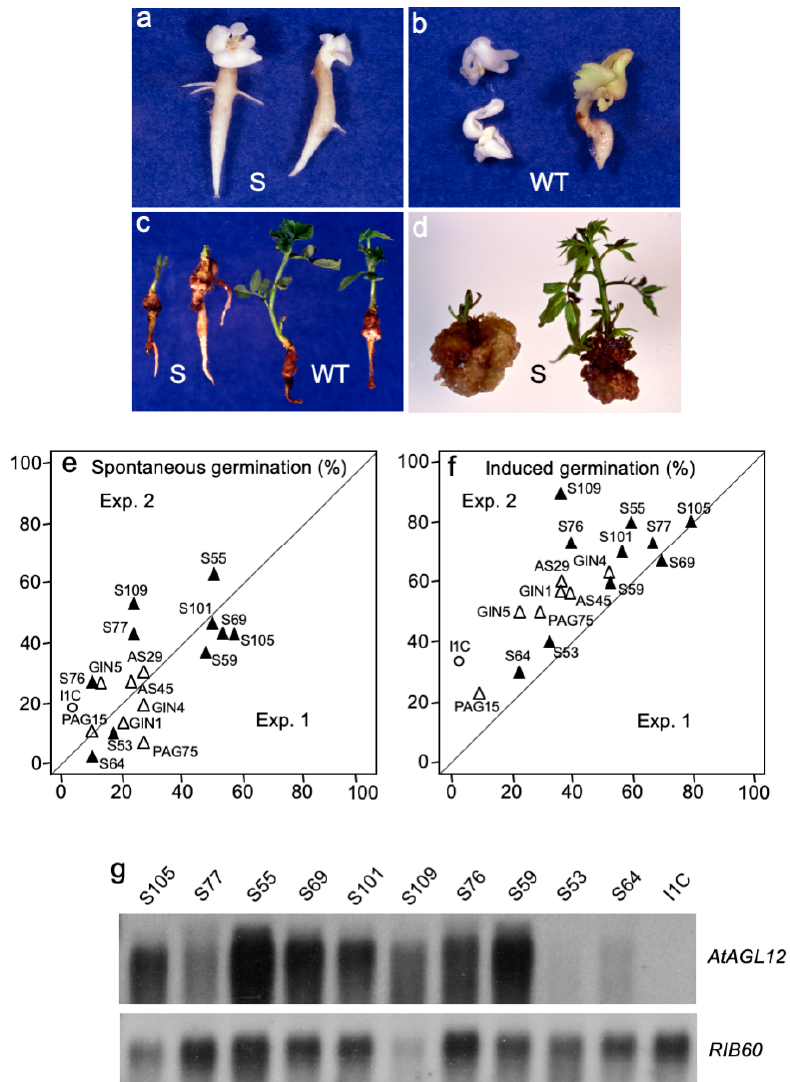
Figure 2. AtAGL12 overexpression in walnut somatic embryos and plantlets. ( a ) Accelerated spontaneous germination of S101 somatic embryos overexpressing AtAGL12 in sense orientation after 3 weeks of horizontal culture. ( b ) Wild-type I1C embryos sampled at the same time as control. Note the earlier initiation of lateral root development among the S embryos; ( c ) conversion of walnut somatic embryos into plantlets. S109 transgenic plantlets (left) and wild type I1C control (right) were photographed after 5 weeks of development in individual tubes. Note the much more important root to shoot ratios for the S plantlets; ( d ) variable micropropagation and shoot development abilities of the transgenic S lines: the S69 line (left) presenting high AtAGL12 expression levels is characterized by poor shoot apical development and important callus development. Conversely, the S64 line (right) characterized by a low transgene expression levels presents a normal shoot apical development; ( e ) spontaneous germination rates of representative walnut somatic embryo S, AS, PAG, GIN and wild type I1C lines were scored after 3 weeks of culture. For each line, the numbers of germinated somatic embryos were determined twice (experiment 1 and 2, n = 3 × 10). ( f ) Induced germination rates were scored after the ablation of the cotyledons and 2 additional weeks of vertical culture (for a total of five weeks of culture). The average germination percentages observed for each S (closed triangles, bold characters), transgenic control (AS, GIN and PAG lines, open triangles) and the wild-type I1C lines (open circle, bold characters) are reported for both experimental repeats and culture times; ( g ) relative expression levels of AtAGL12 detected in mature non-germinated embryos of the selected walnut transgenic S lines revealed by northern-blot. A walnut Rib60S cDNA probe was used as reference.